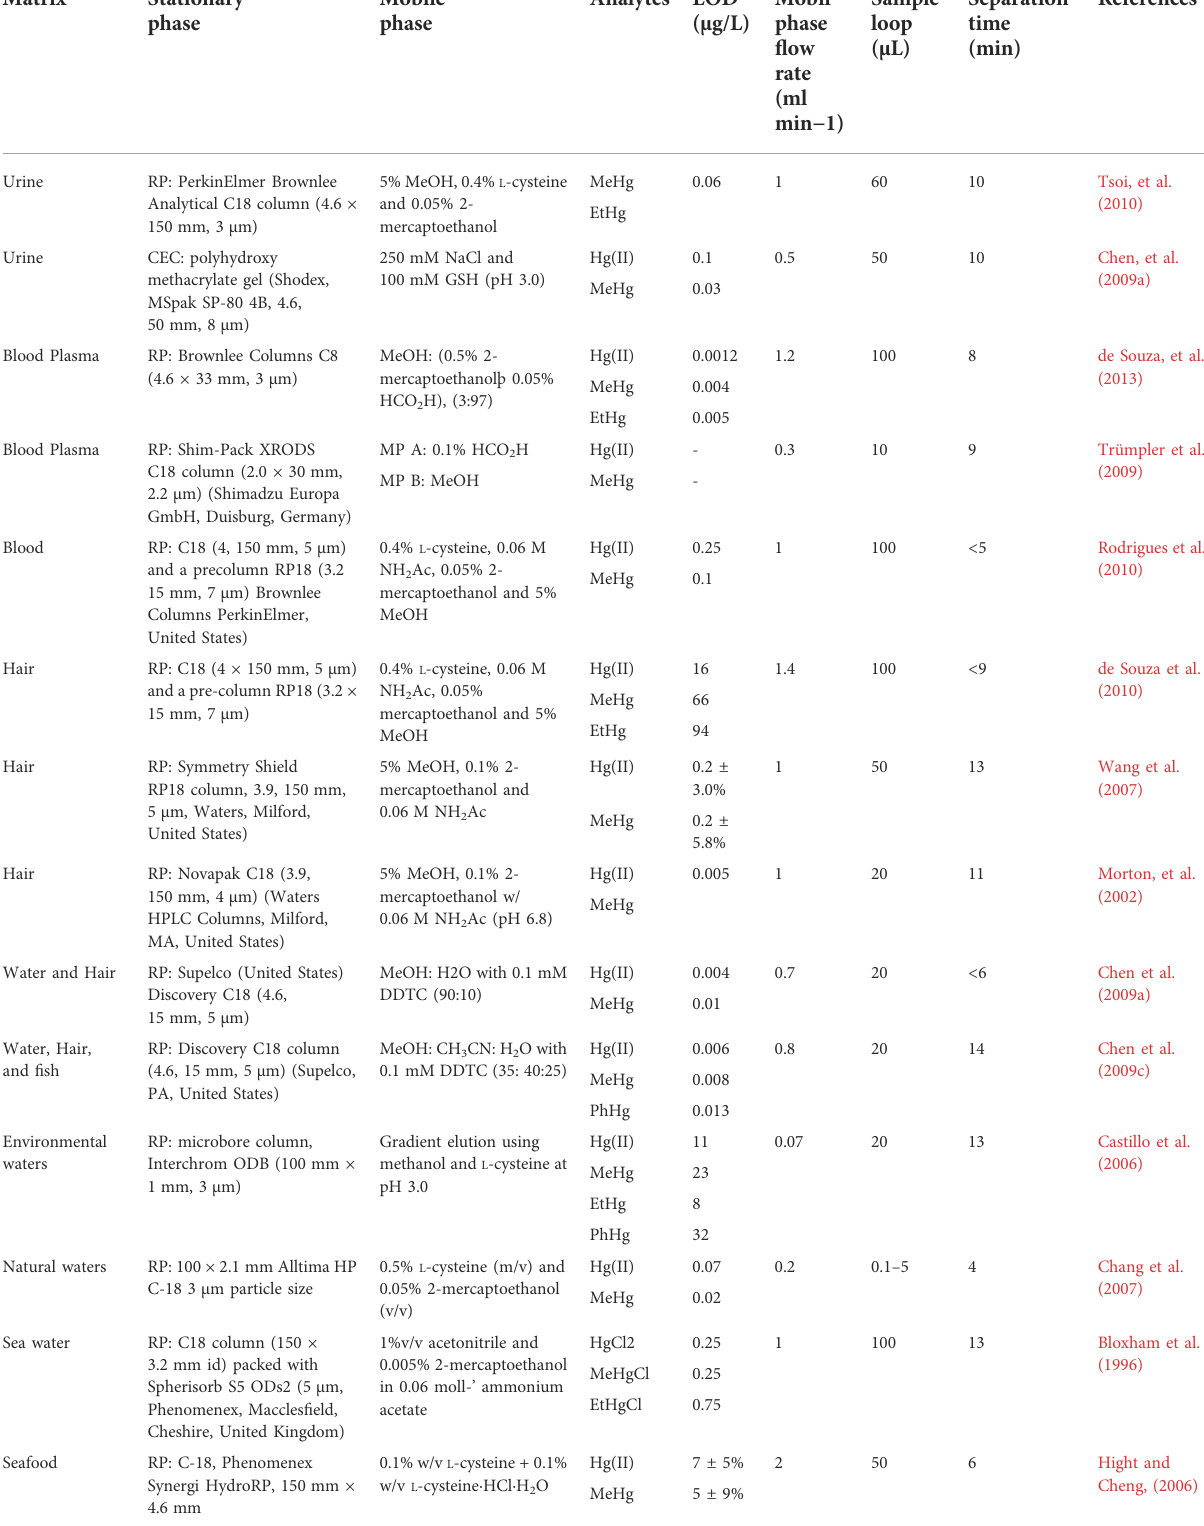
TABLE 2 Chromatographic conditions adopted for the separation of mercury species.